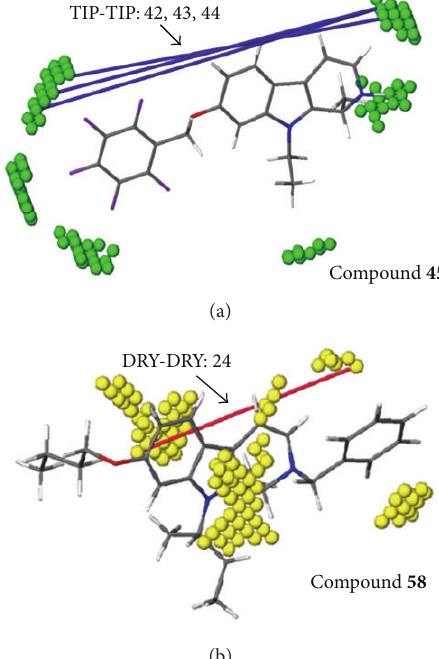
Figure 3: Association of structural fragments with GRIND vari- ables. Nodes were selected using ALMOND filtering for DRY and TIP probes. Distances in red are favorable whereas distances in blue are not favorable for antitumor potency.